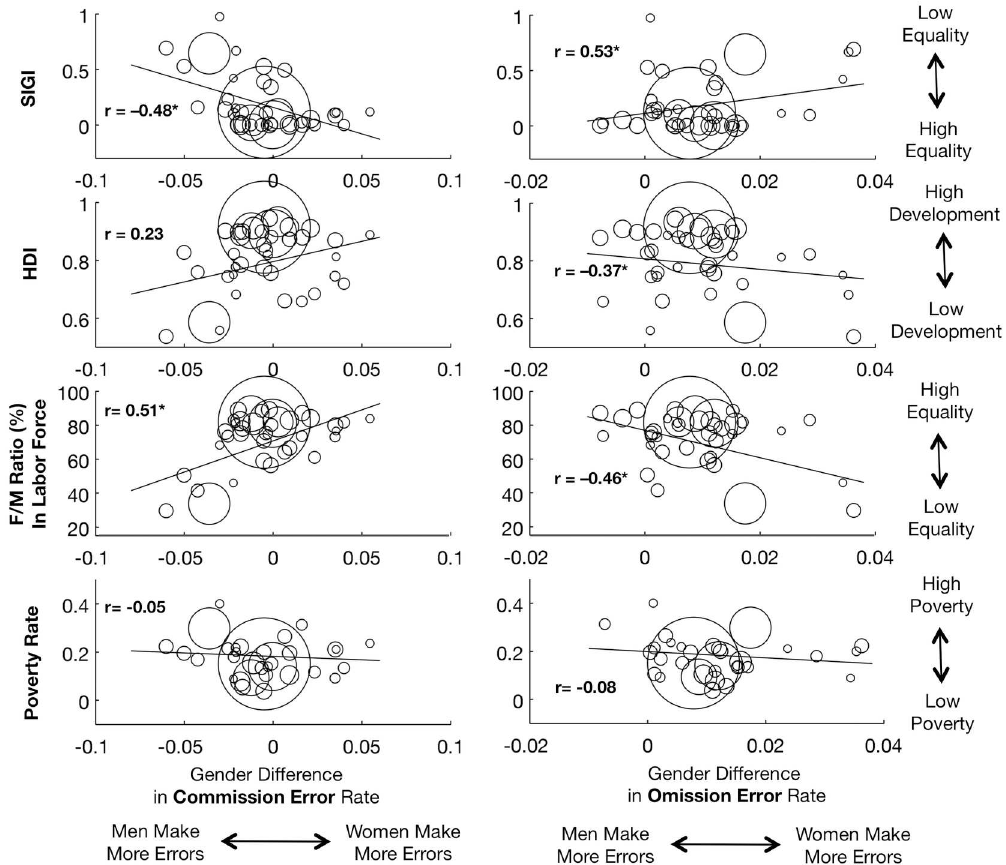
Fig 3. Gender difference in omission and commission error rate versus three sociocultural indices. Social Institutions and Gender Index (SIGI), Human Development Index (HDI), and female/male ratio of labor force participation. Residualized gender difference is averagewomen’s age-corrected score minus averagemen’s age- corrected score. A negative gender differenceindicates that men made more errors than women; a positive gender difference indicatesthat women made more errors than men. Circle area reflects the number of participants from that country, N = 16,552 people, 40 countries. Linear trendline calculated using unweighted country averages. * indicates significance after FDR